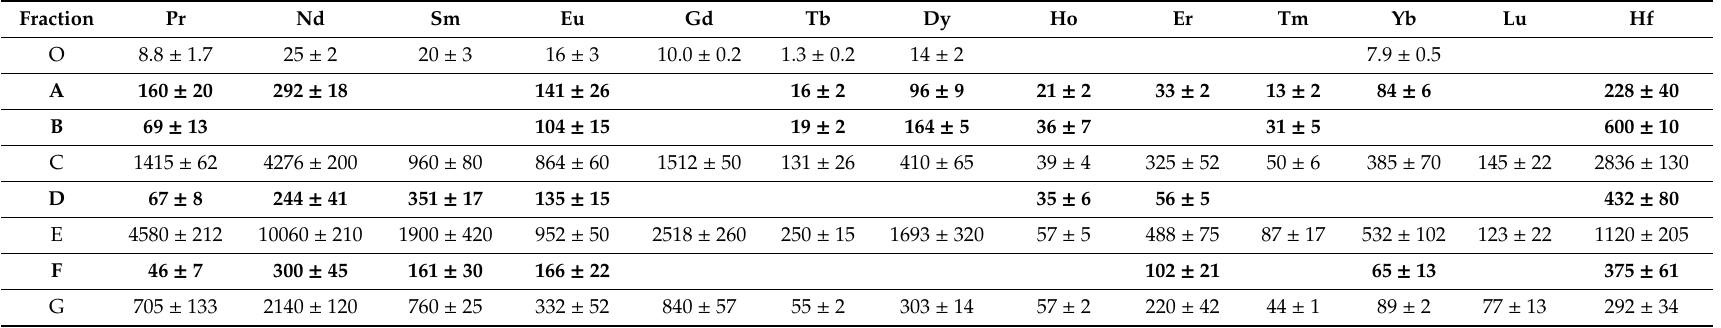
Table 3. Concentrations ( µ g g − 1 ) found for trace elements in the di ff erent fractions of the winemaking process without added yeast